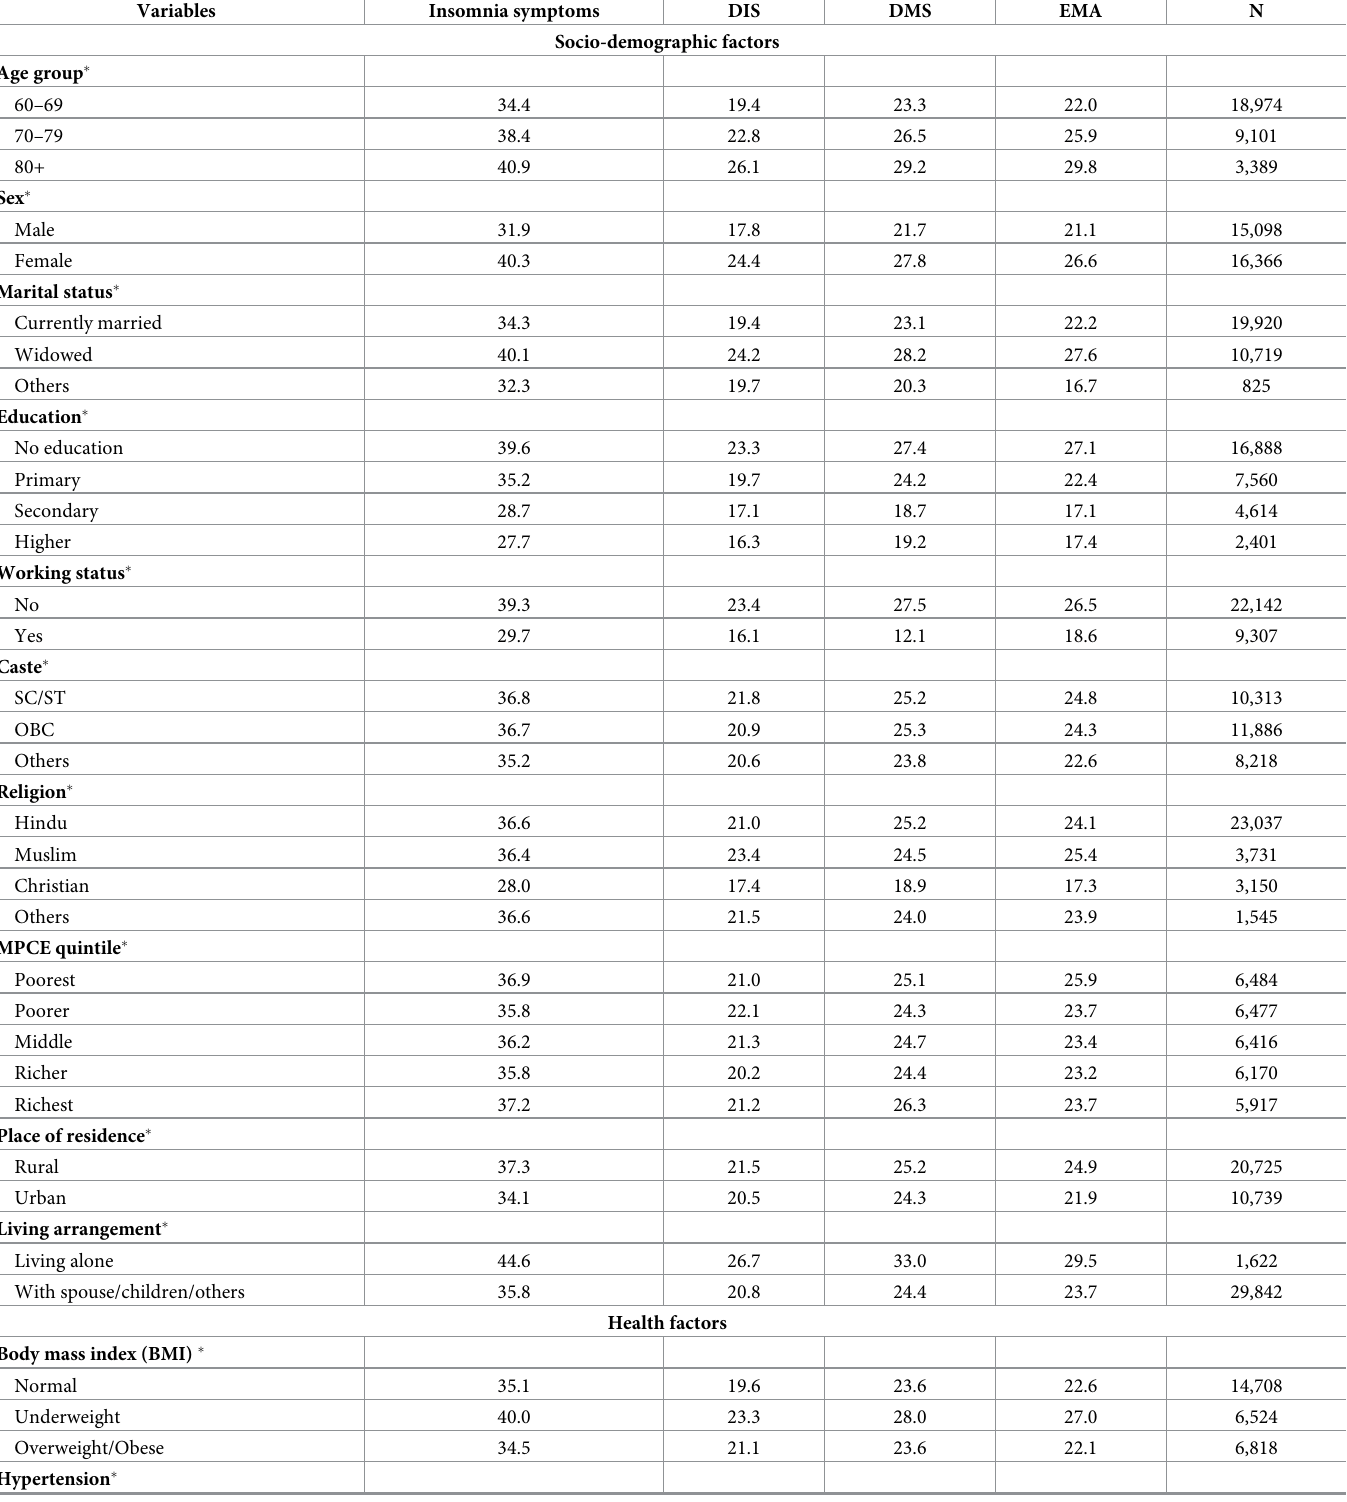
Table 2. Percentage of individuals aged 60 years and above with insomnia symptoms by socio-demographic, health and life-style factors.